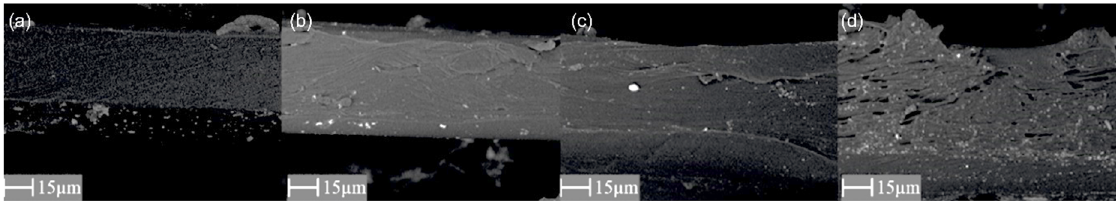
Figure 4. SEM image of membrane cross section with ZIF-8 added; ( a ) PEBAX 2533 + 0 wt% ZIF-8, ( b ) PEBAX 2533 + 2 wt% ZIF-8, ( c ) PEBAX 2533 + 5 wt% ZIF-8, ( d ) PEBAX 2533 + 10 wt%